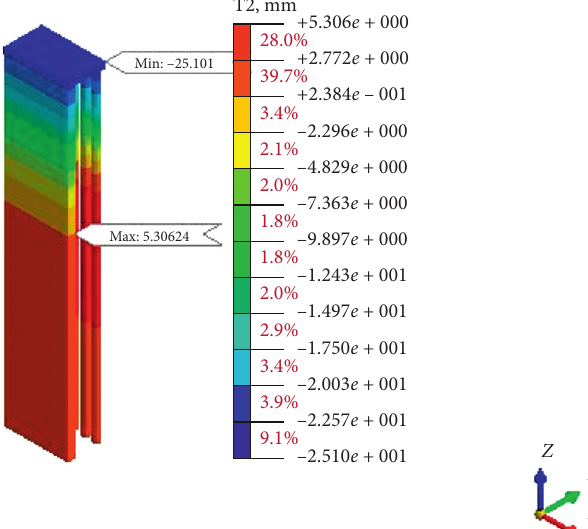
Figure 17: Horizontal displacement of supporting structure after the foundation pit excavation after wharf backfilling (unit: mm).